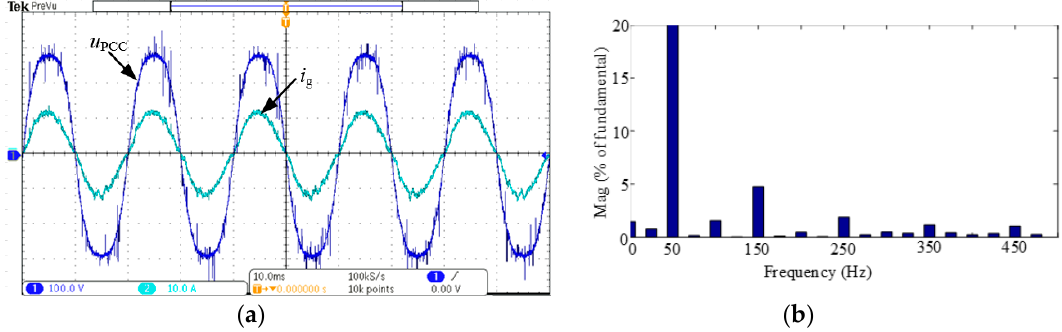
Table 2. THD of grid current under different harmonic suppression schemes. Figure 21. The experimental results of the proposed control strategy. ( a ) Waveforms of grid voltage and current, and ( b ) the FFT analysis of grid current (THD = 5.75%).